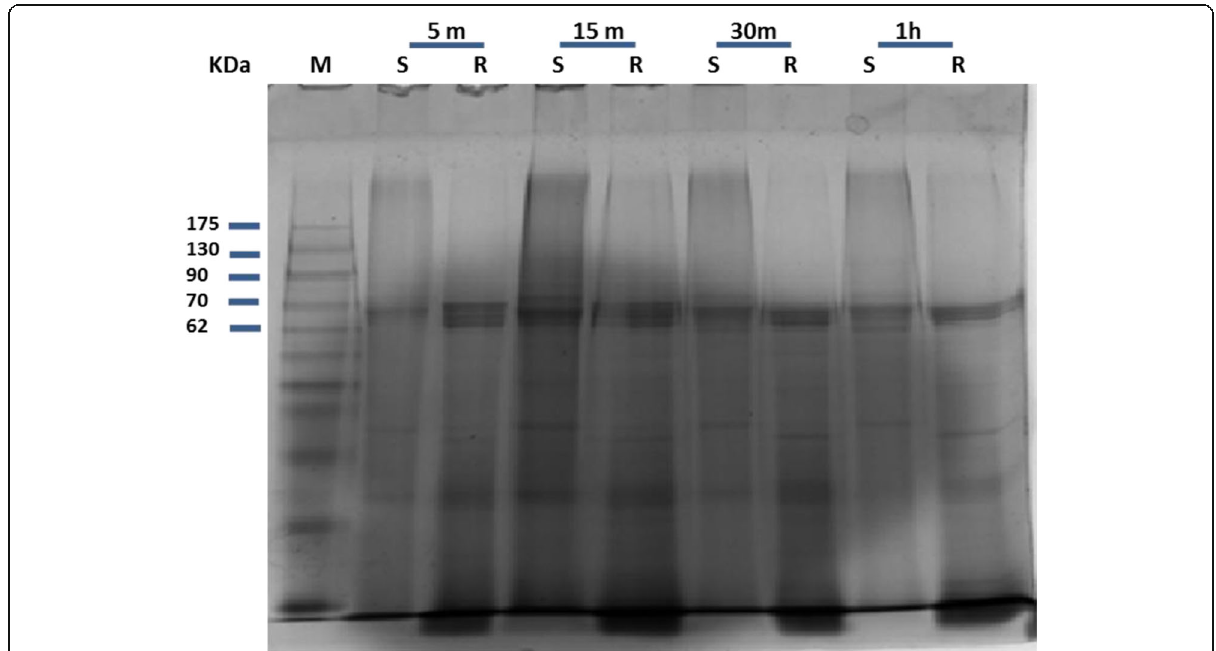
Fig. 2 Hydrolysis of Cry1C toxin by the gut extract of Spodoptera littoralis susceptible and resistant lines incubated at different time intervals, viz., 5, 15, 30, and 60 min. M, page ruler marker; S, susceptible lane; R, resistant